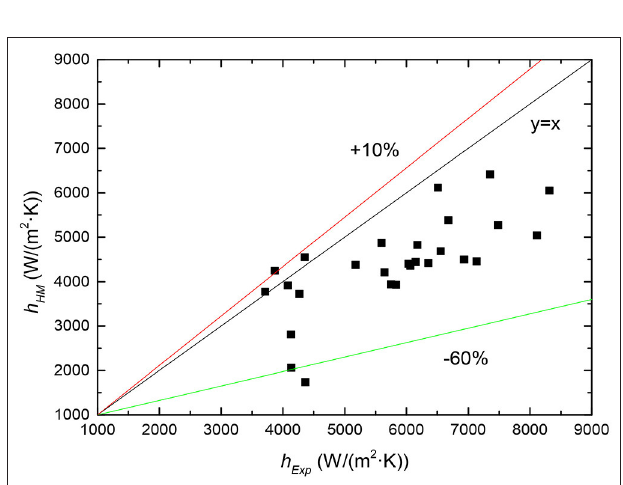
FIGURE 15 | The relative error at low pressure.